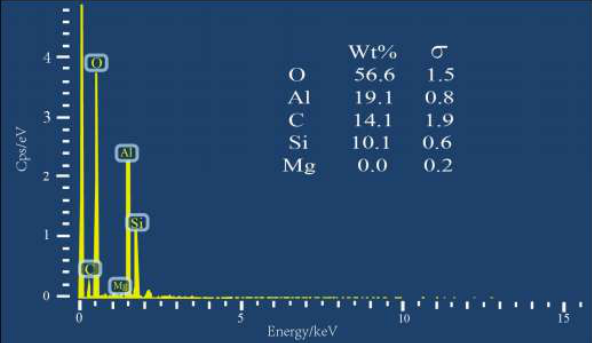
Figure 8. Composition table of silicone rubber (EDS) [19].